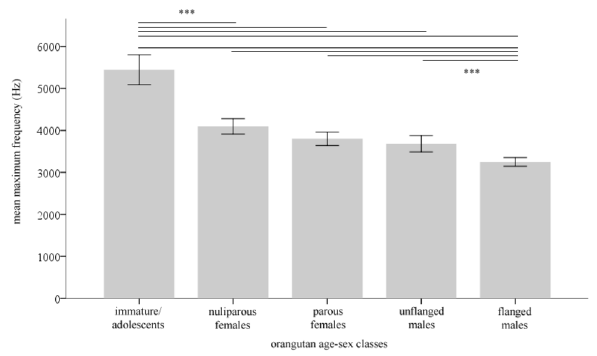
Figure 3. Mean maximum frequency (Hz) per orangutan age-sex class of the kiss-squeak unaided at Cabang Panti. Immature/adolescent, N = 6, N = 149; Nulliparous calls female, n = 2, N = 104; Parous female, N = 7, N = 75; calls calls Unflanged male, N = 2, N = 49; Flanged male, N = 4, N = calls calls 337. Error bars: +2 s.e. *** p = 0.001. doi: